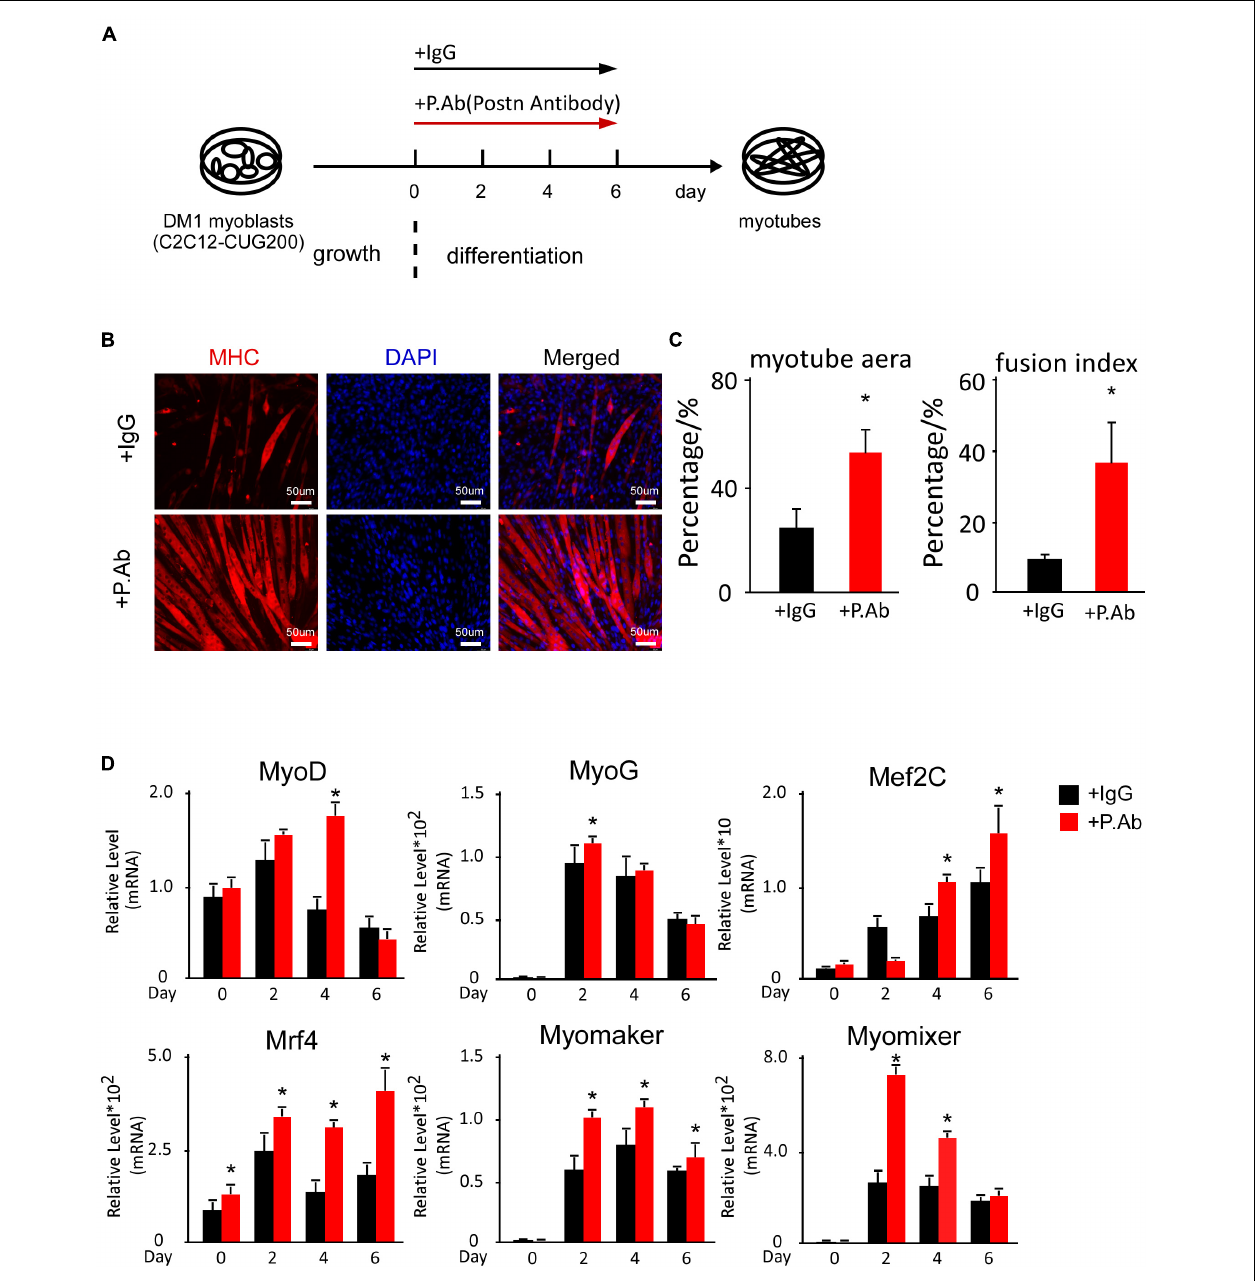
FIGURE 6 | POSTN-neutralizing antibody treatment rescued myogenesis defects in DM1 myoblast cells. (A) Schematic diagram of the myoblast differentiation processes of DM1 myoblast cells treated with control IgG and POSTN-neutralizing antibody. (B) Myotube formation in both control IgG and POSTN-neutralizing antibody groups, detected by immunostaining against MHC at differentiation day 6. (C) Myotube area and fusion index in both groups quantified with ImageJ software. (D) Expression levels of MRFs ( MyoD , MyoG , Mef2C , and Mrf4 ) and fusion markers ( Myomaker and Myomixer ) in both groups, measured by RT-qPCR. All expression levels were normalized to the values of the control IgG group at day 0. IgG, control IgG antibody; P.Ab, POSTN neutralizing antibody; * P <